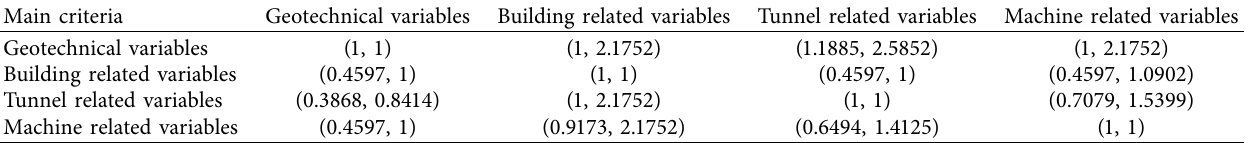
Table 6: Te interval multiplicative matrix of the main criteria.